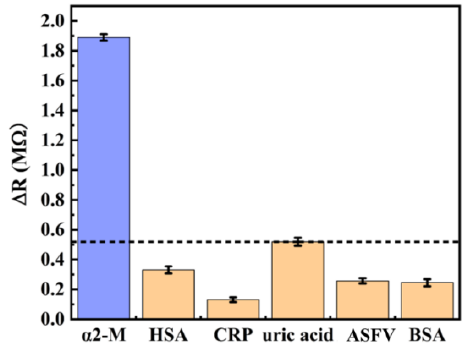
Figure 11. Specificity measurement of the biosensor.